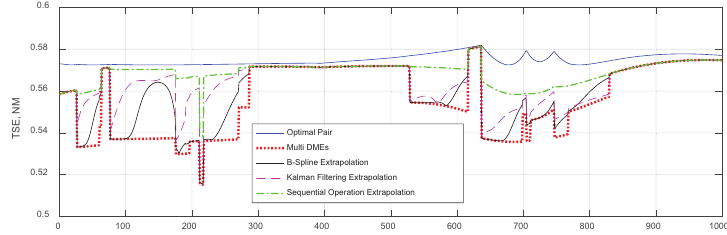
Figure 11. HDOP coefficient in case of B-spline extrapolation